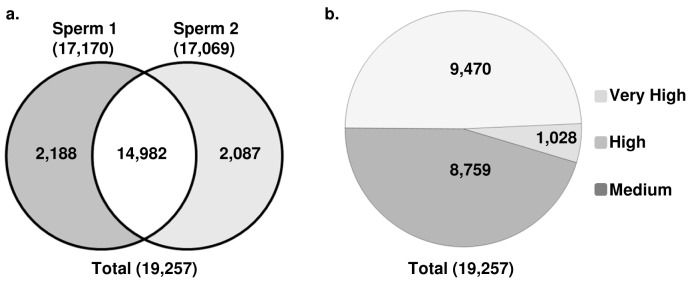
Summary statistics for mapped RNA sequence tags: (a) Comparison of mapped tags (AC≥1) between the two sperm samples; (b) Proportions of tags with very high (AC≥100), high (10<AC<100), and medium (1≤AC≤10) expression.